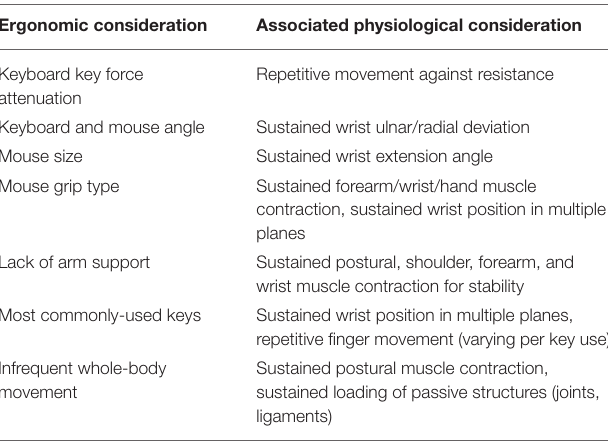
TABLE 1 | Ergonomic considerations for repetitive and sustained loading and potential elevated injury risk. Ergonomic